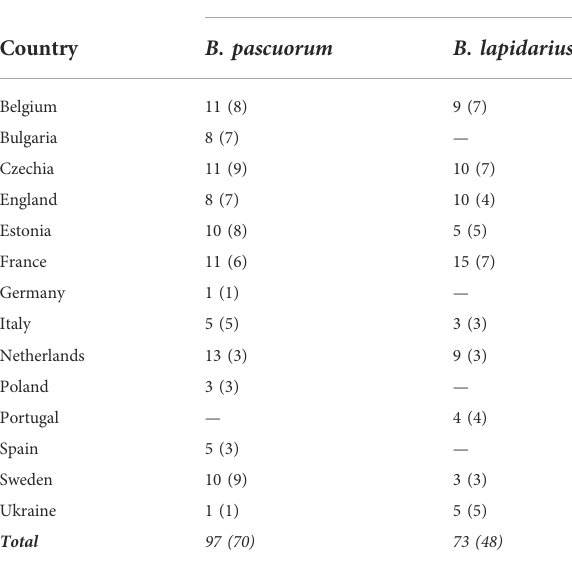
TABLE 1 The total number of specimens by country and species that have been RAD sequenced and remained after fi ltering, with the number of sampling sites in parentheses, and total numbers in